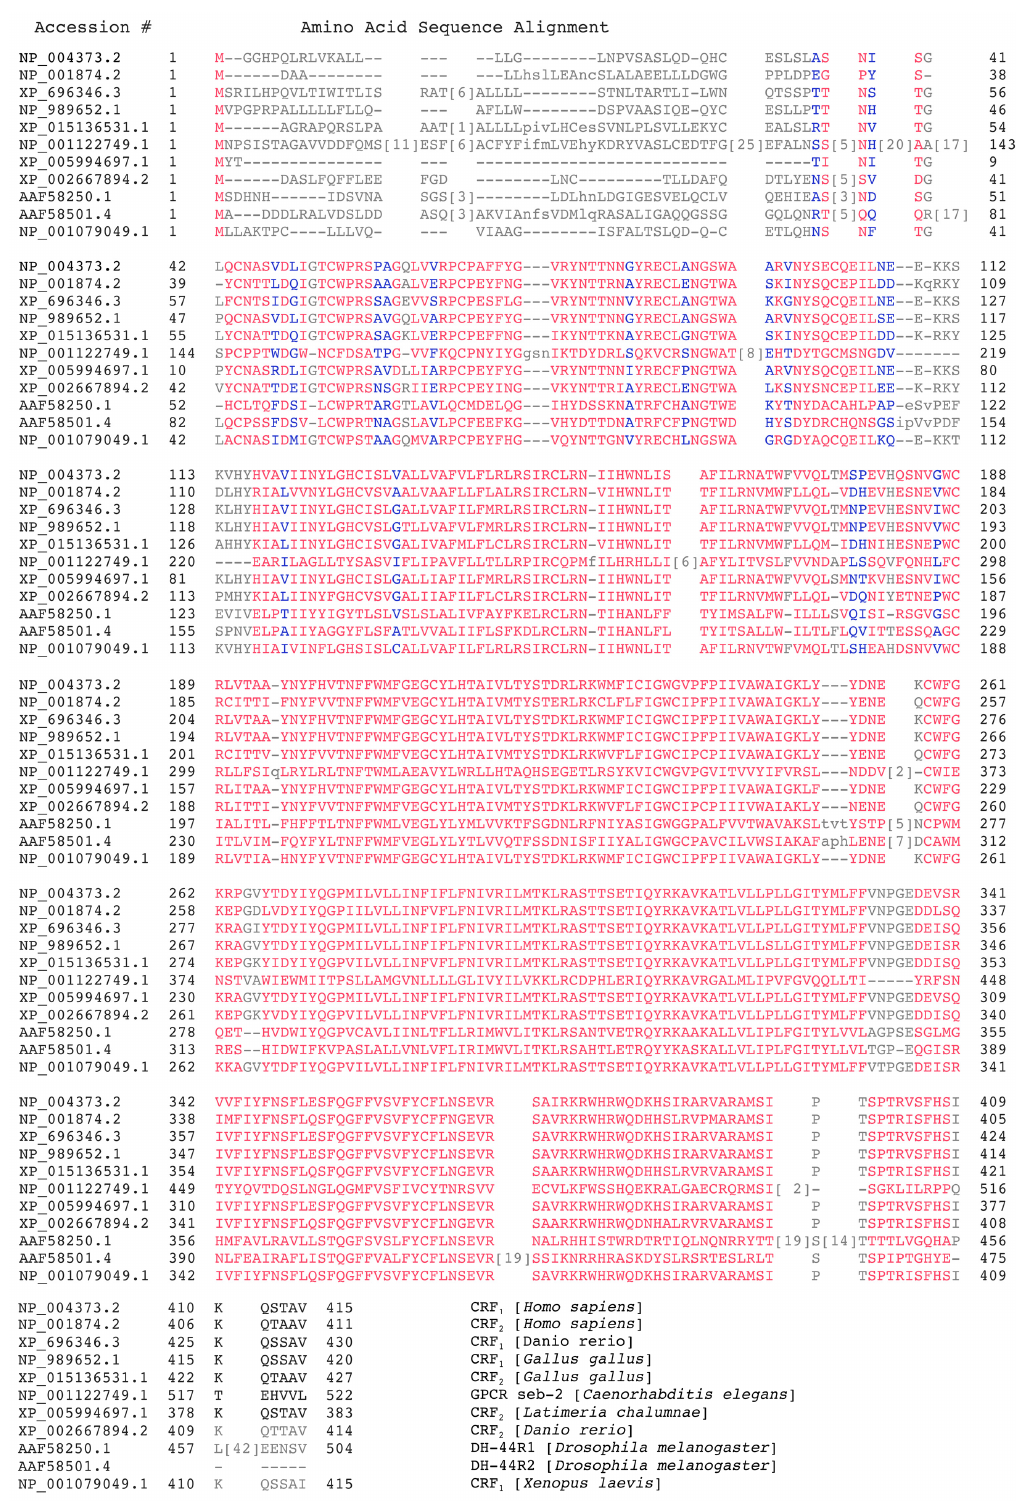
Figure 4. A comparison of examples of primary amino acid sequence from CRF receptors and their closely related GPCRs, seb-2, and diuretic hormone 44 receptors found in the Protein data bank and generated using the multiple alignment tool from NCBI Blast. Red and blue are alignment columns with no gaps, whereas grey residue are aligned with gaps. Highly conserved amino acids are shown in red, and less conserved are shown in blue based on the residues’ relative entropy thresholds.